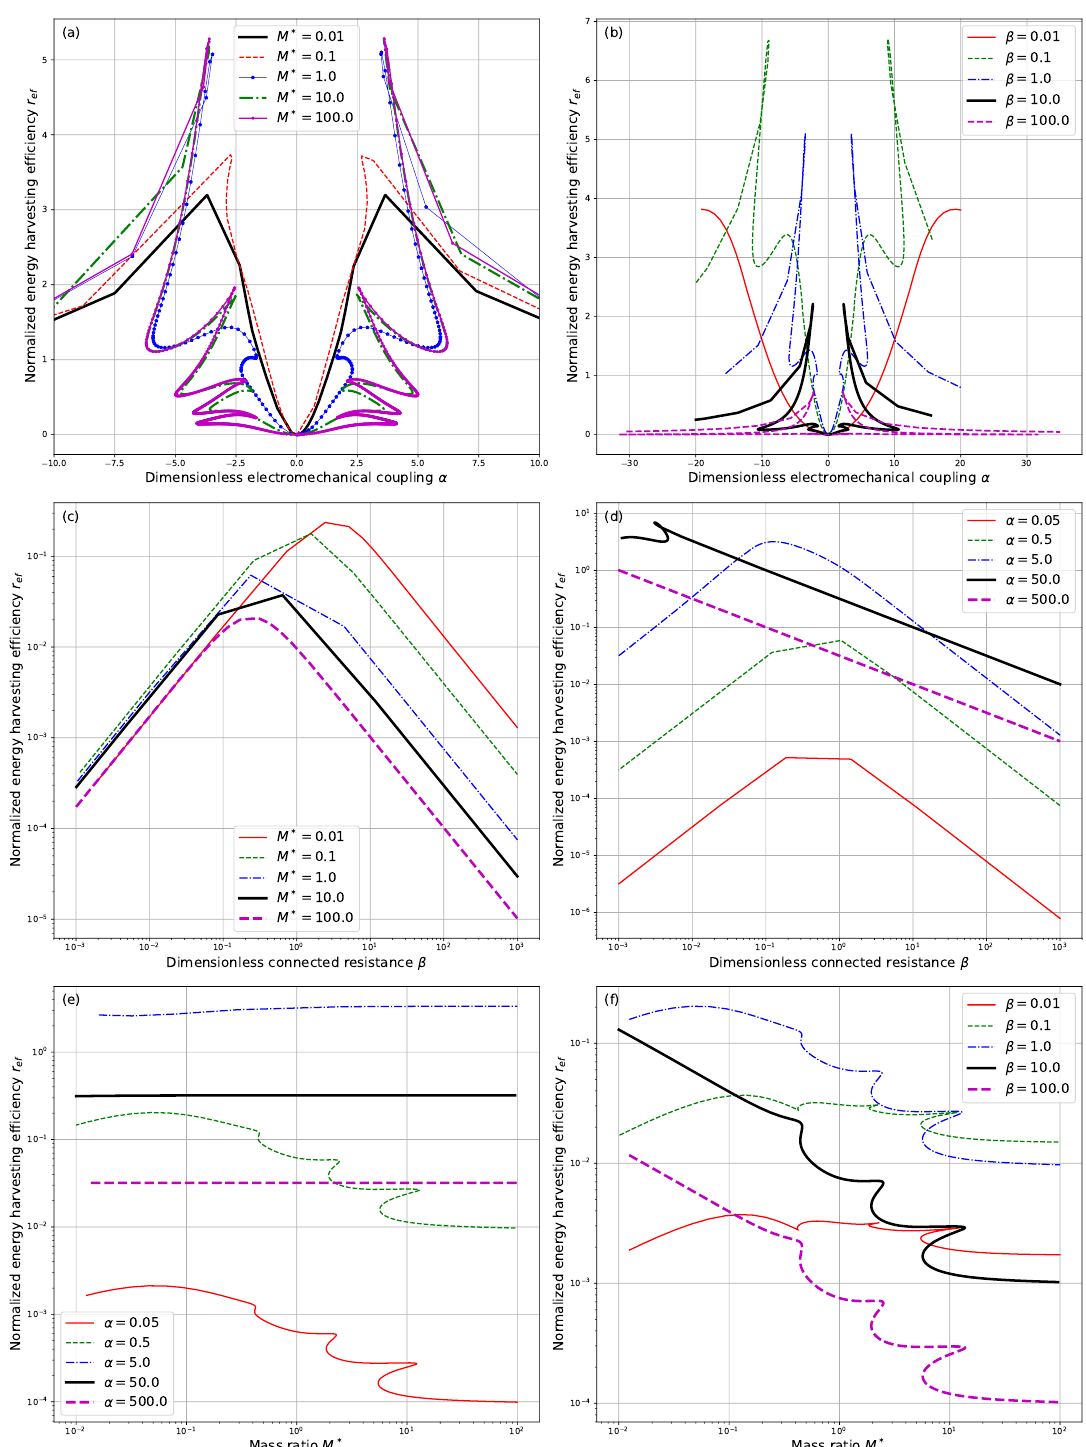
Figure 9. Dependence of the normalized energy harvesting efficiency r ef upon ( a ) the dimensionless electromechanical coupling α with β = 1.0 and different values of M ∗ ; ( b ) the dimensionless connected resistance β with α = 0.5 and different values of M ∗ ; ( c ) the mass ratio M ∗ with β = 1.0 and different values of α ; ( d ) the dimensionless electromechanical coupling α with M ∗ = 1.0 and different values of β ; ( e ) the dimensionless connected resistance β with M ∗ = 1.0 and different values of α ; and ( f ) the mass ratio M ∗ with α = 0.5 and different values of β